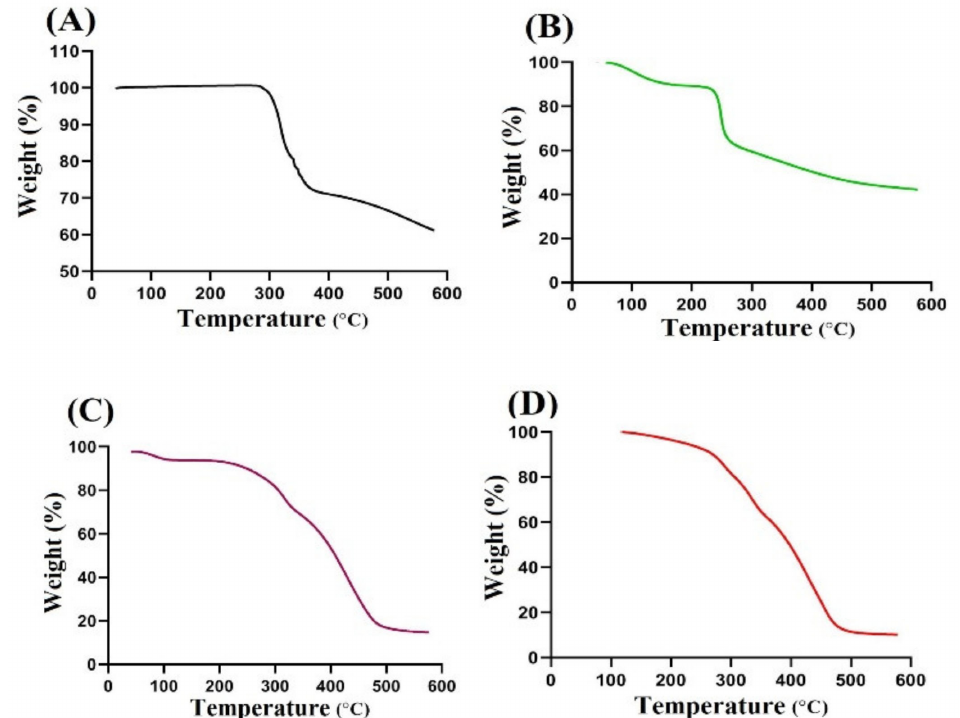
Figure 2. TGA (Thermogravimetric analysis) of ( A ) DS (Diclofenac sodium), ( B ) CS (Chondroitin sulfate), ( C ) CBP (Carbopol), and ( D ) CS/CBP-co-PAA